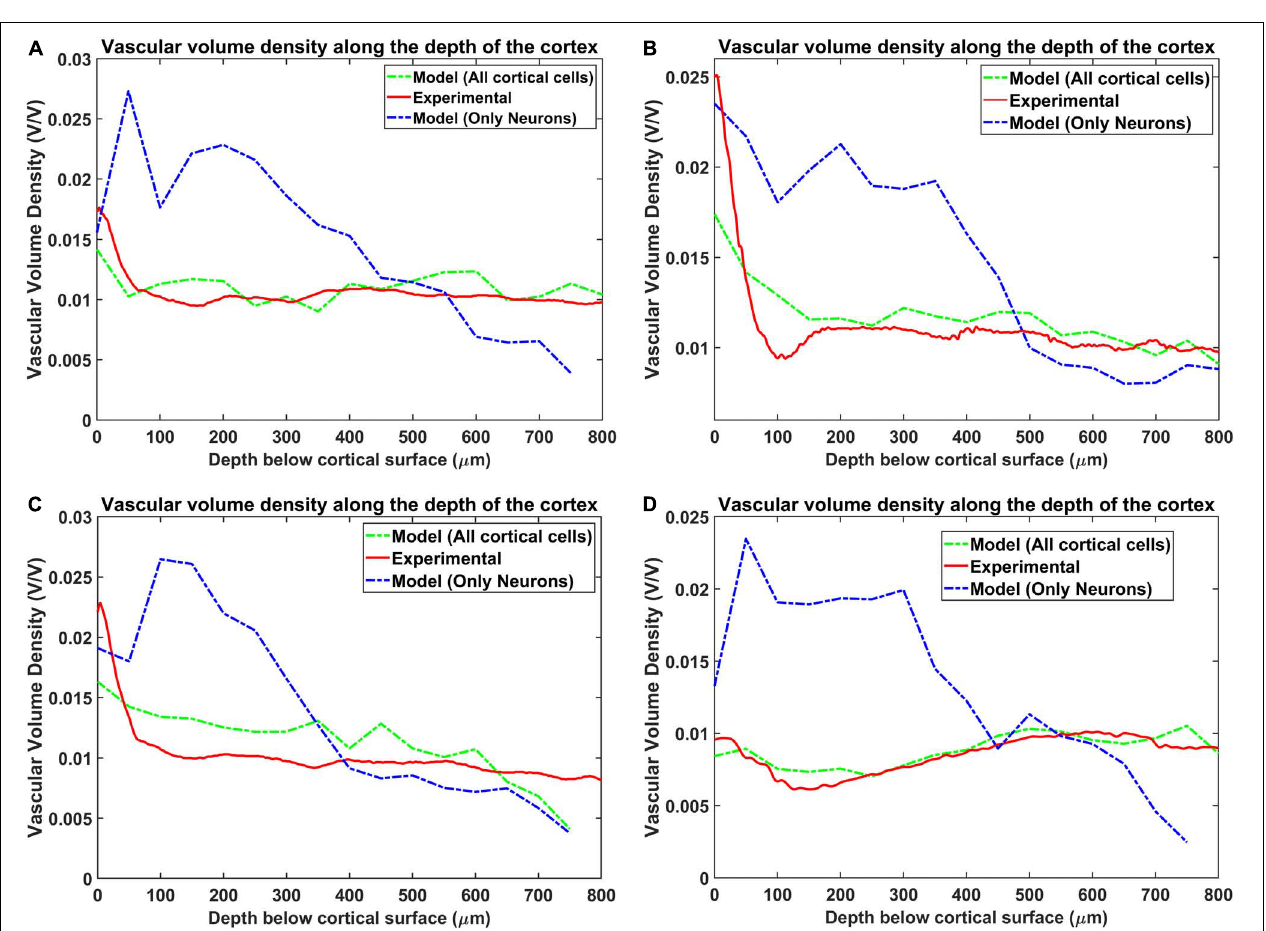
FIGURE 7 | Comparison of the vascular volume density from all the four regions when considering neurons alone and both neurons and non-neural cells. The four regions are (A) agranular cortex which was measured 1 mm anteroposterior and 1 mm mediolateral of the Bregma, (B) partially granular cortex measured –1 mm anteroposterior and 1 mm mediolateral of the Bregma, (C) partially granular cortex measured 2 mm anteroposterior and 1 mm mediolateral of the Bregma, and (D) granular cortex measured 1 mm anteroposterior and 4 mm mediolateral of the Bregma. The experimental data is from Tsai et al. (2009).